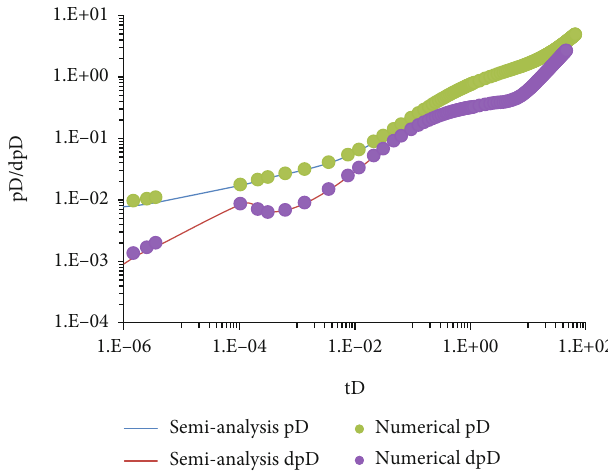
Figure 11: Comparison between numerical results and semianalysis